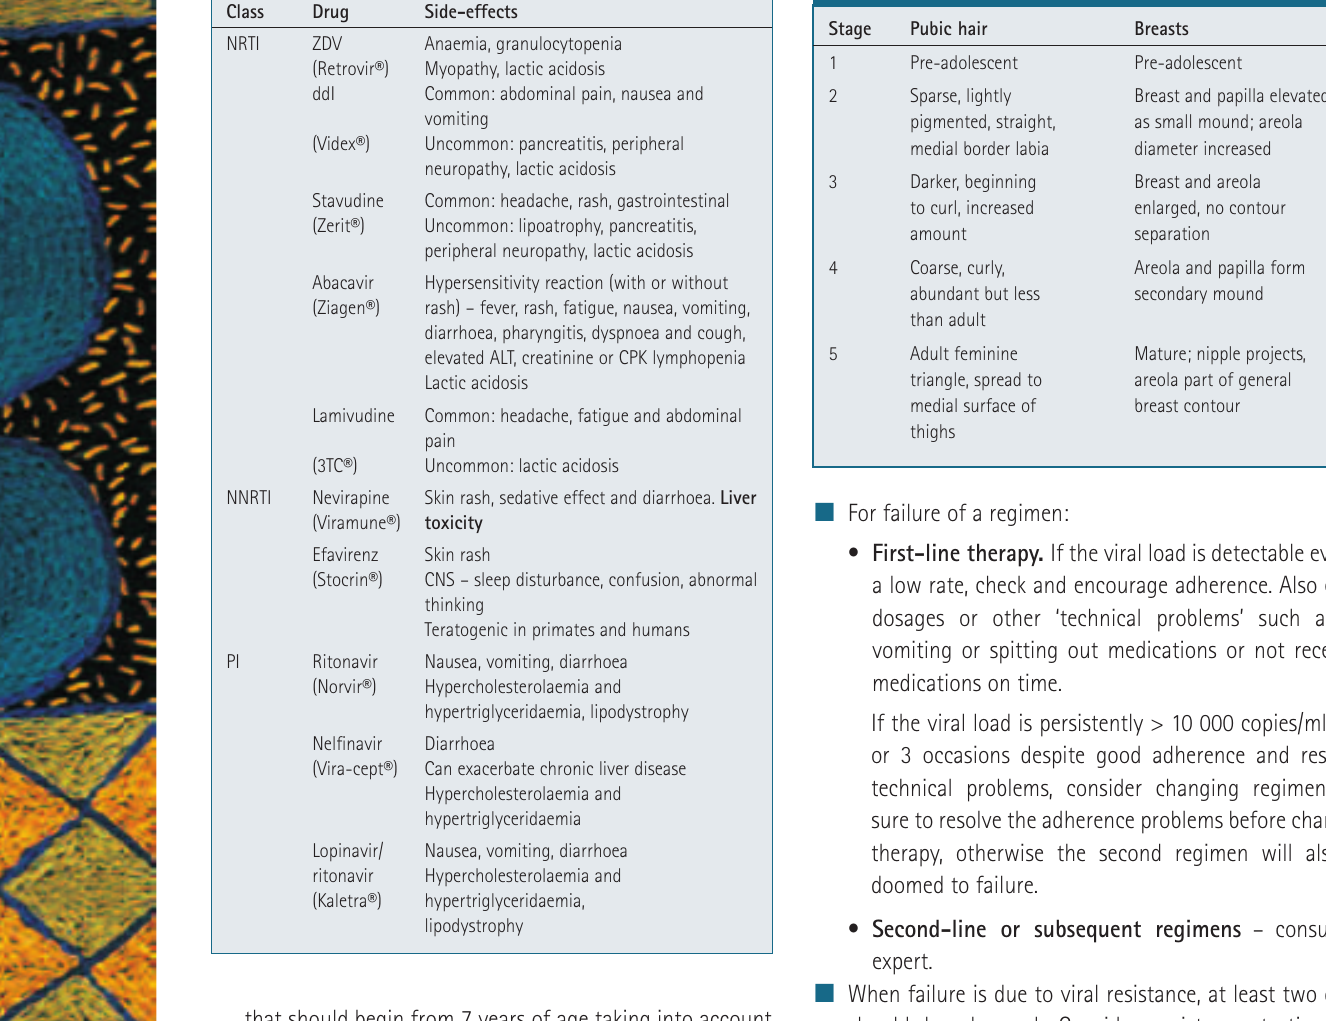
TABLE XI. TANNER STAGING FOR GIRLSTABLE IX. SIDE-EFFECTS OF ARVs IN